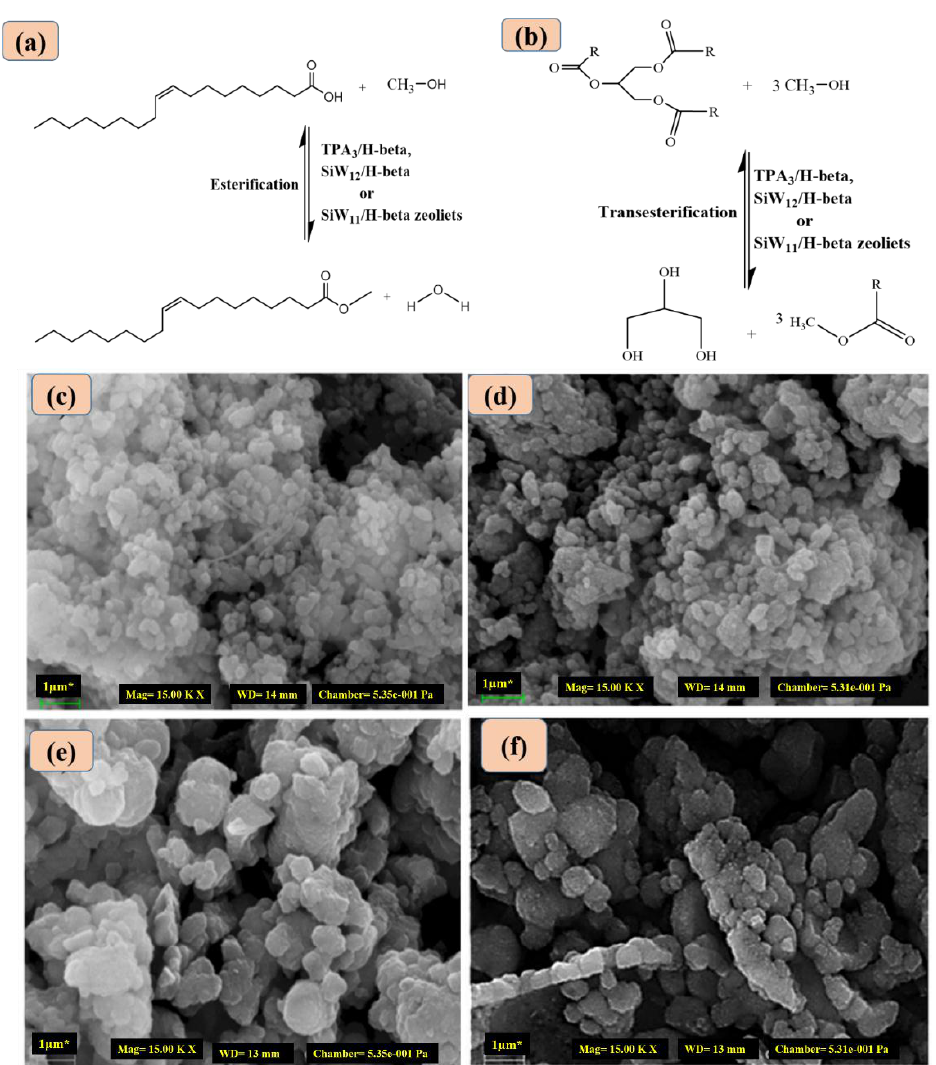
Figure 2. ( a ) Esterification of oleic acid and ( b ) transesterification of triglyceride with methanol over heterogeneous acid catalysts comprised of H-β-zeolite. Scanning electron microscopy (SEM) images for ( c ) H-beta, ( d ) TPA 3 /H-beta, ( e ) SiW 12 /H-beta, and ( f ) SiW 11 /H-beta [55–57] .